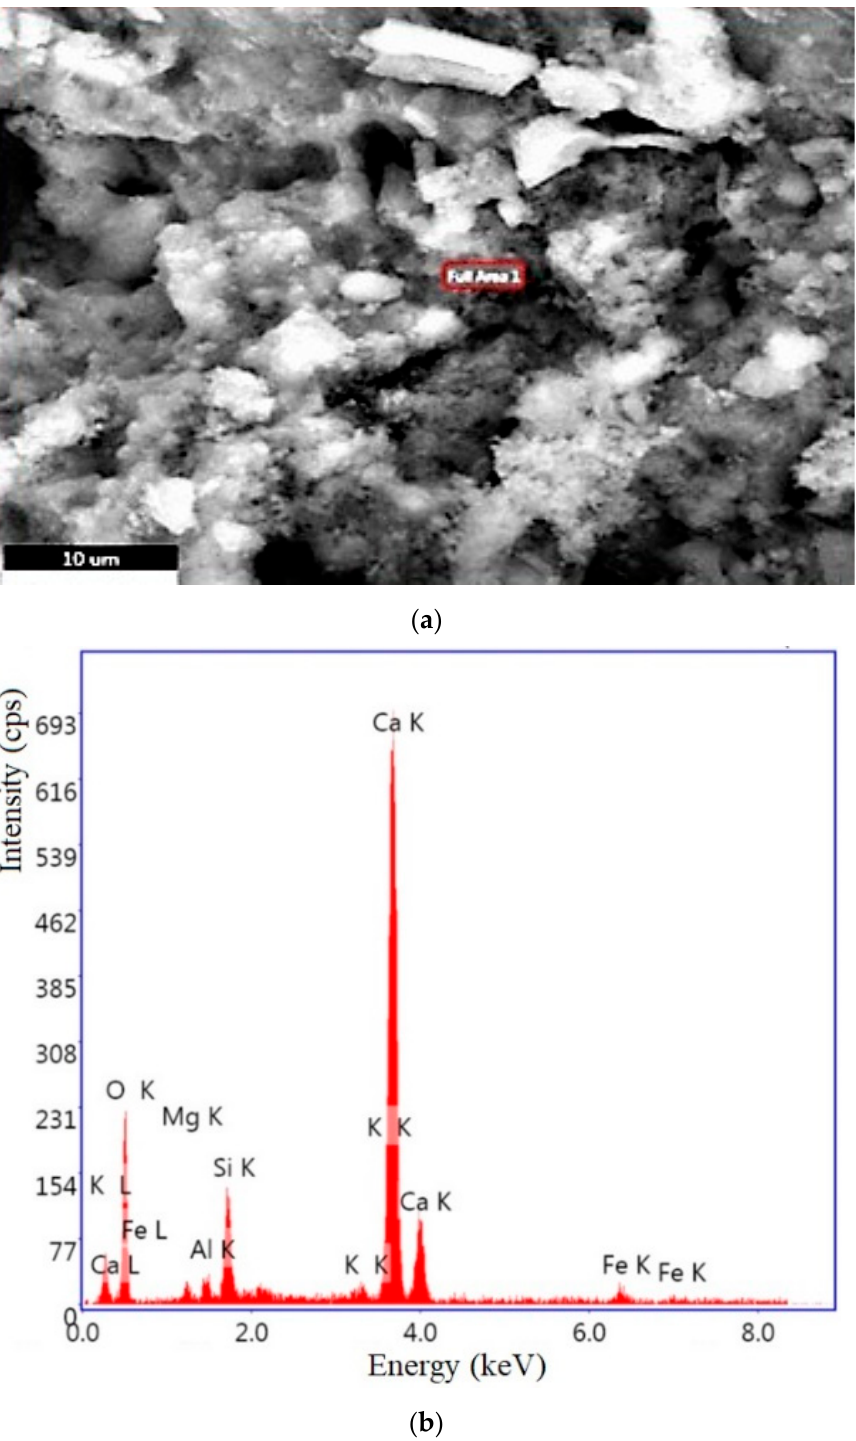
Figure 9. Scanning electron microscopy image ( a ) associated with EDX analysis ( b ) for sample A.